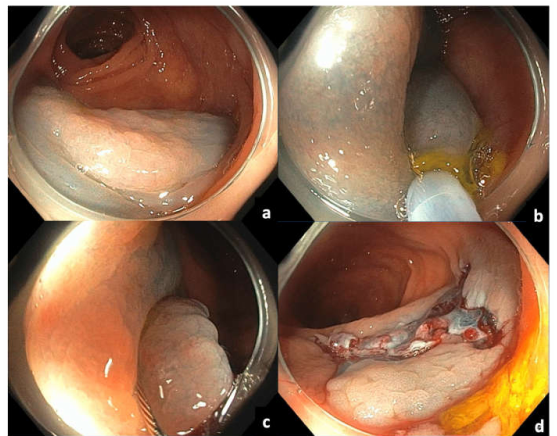
Figure 4. Cold EMR of sessile serrated ascending colon polyp: ( a ) Sessile serrated polyp in ascending colon following submucosal injection; ( b , c ) piecemeal resection with cold snare, taking into consideration adequate overlap of resection pieces and clear margins; ( d ) post-resection mucosal